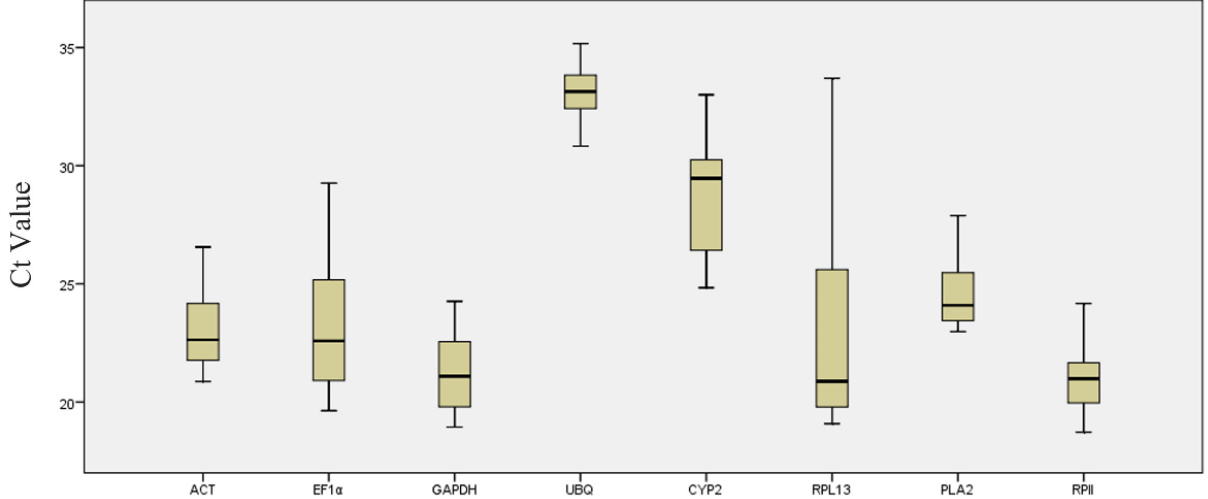
Figure 1. RT-qPCR C t values for reference genes. Expression data are shown as C t values for each reference gene in all K. paniculata samples. A line across the box depicts the median. The box indicates the 25th and 75th percentiles. Whiskers represent the maximum and minimum values.